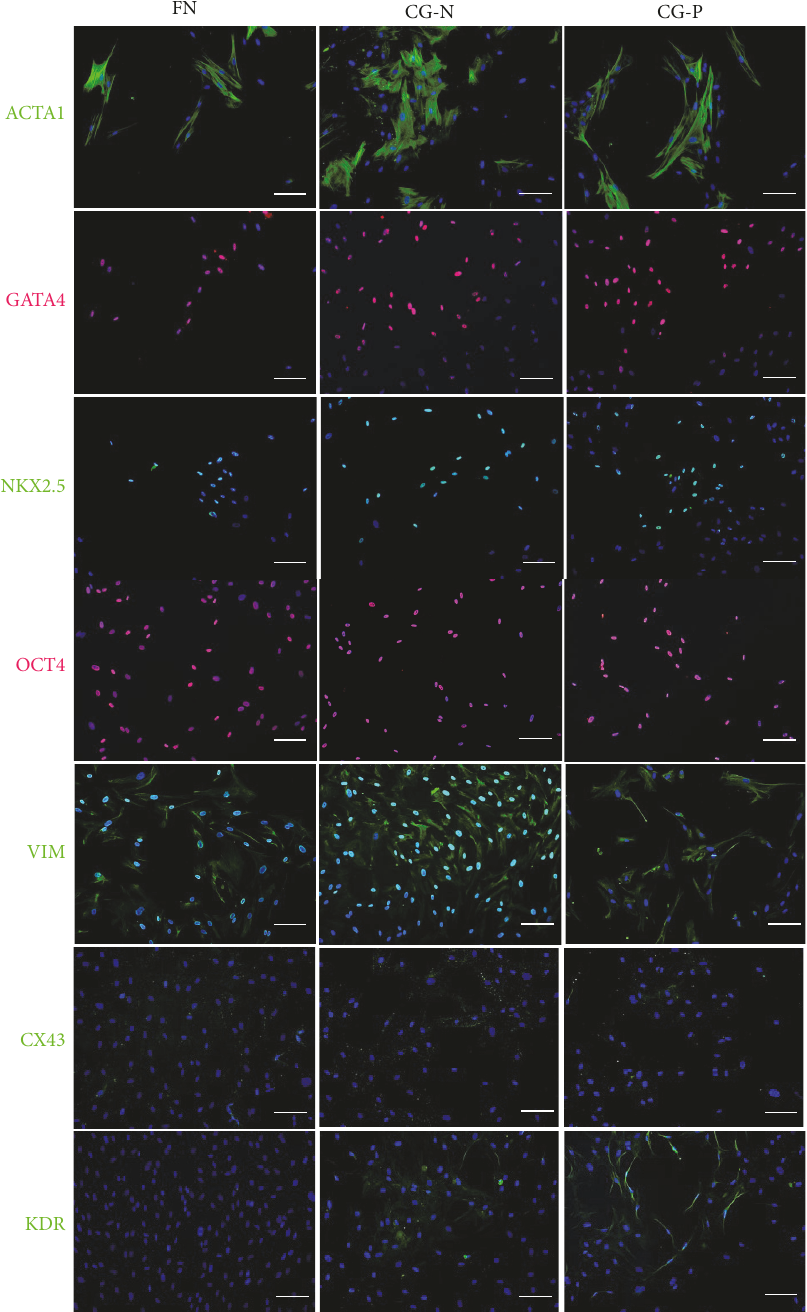
Figure 3: Immuno fl uorescence phenotype of CDCs from normal and pathological cardiogels. Representative CDC immuno fl uorescence images showing no di ff erences in the distribution of the proteins ACTA1, GATA4, NKX2.5, OCT4, and VIM between cells grown on CG- N and CG-P. The protein expression of Cx43 and KDR increases in CDCs cultured on cardiogel. Scale bars =100 μ m. FN: fi bronectin; CG-N: normal cardiogel; CG-P: pathological